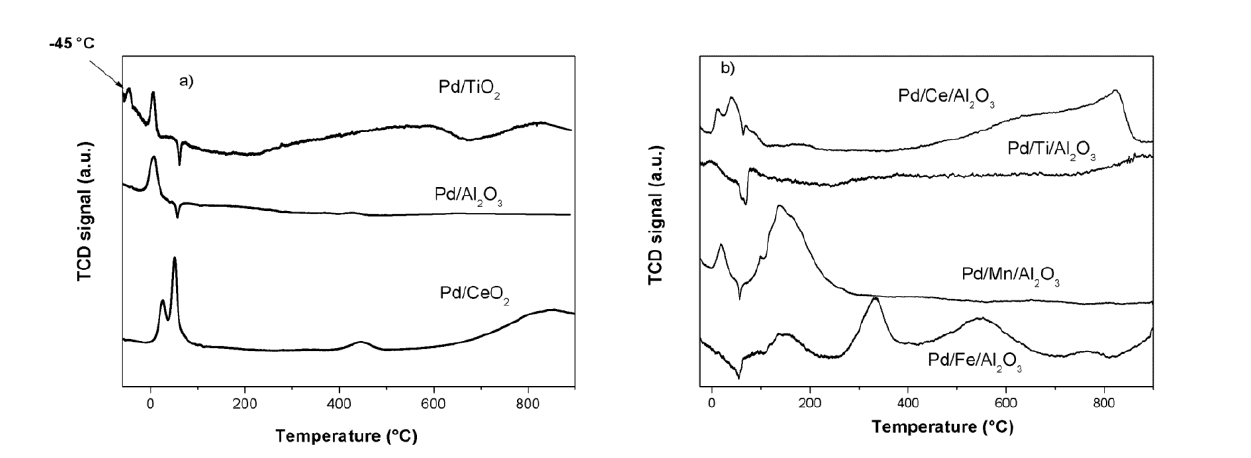
Figure 4. Temperature-programmed reduction (TPR) curves of ( a ) Pd-supported catalysts and ( b ) Pd-doped-supported